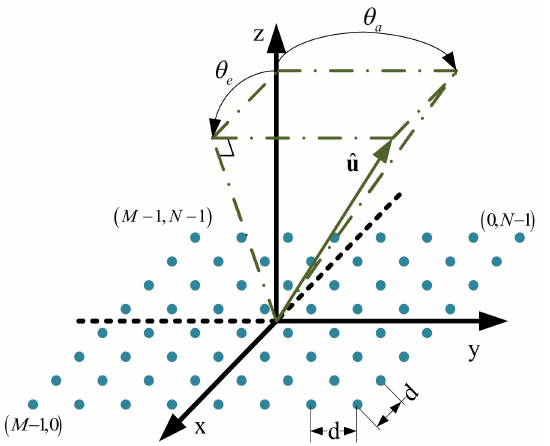
Figure 2. Definition of elevation and azimuth for a 8 × 8 2-D